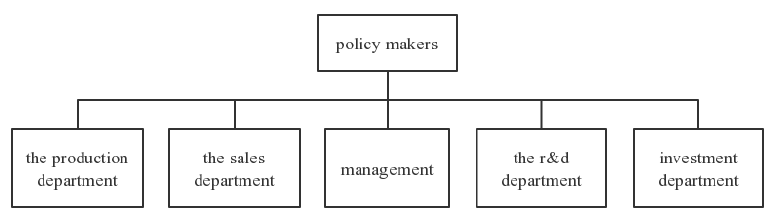
Fig. 1 Organisational chart of the enterprise.